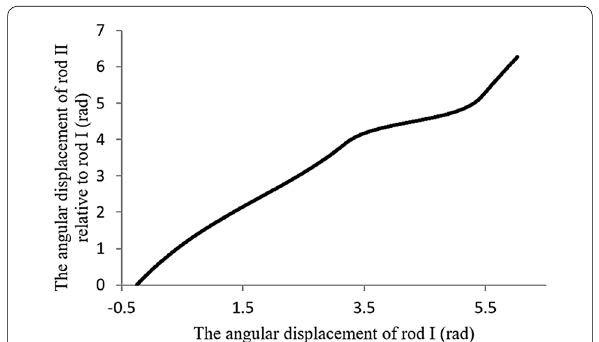
Figure 9 Angular displacement of rod I and rod II